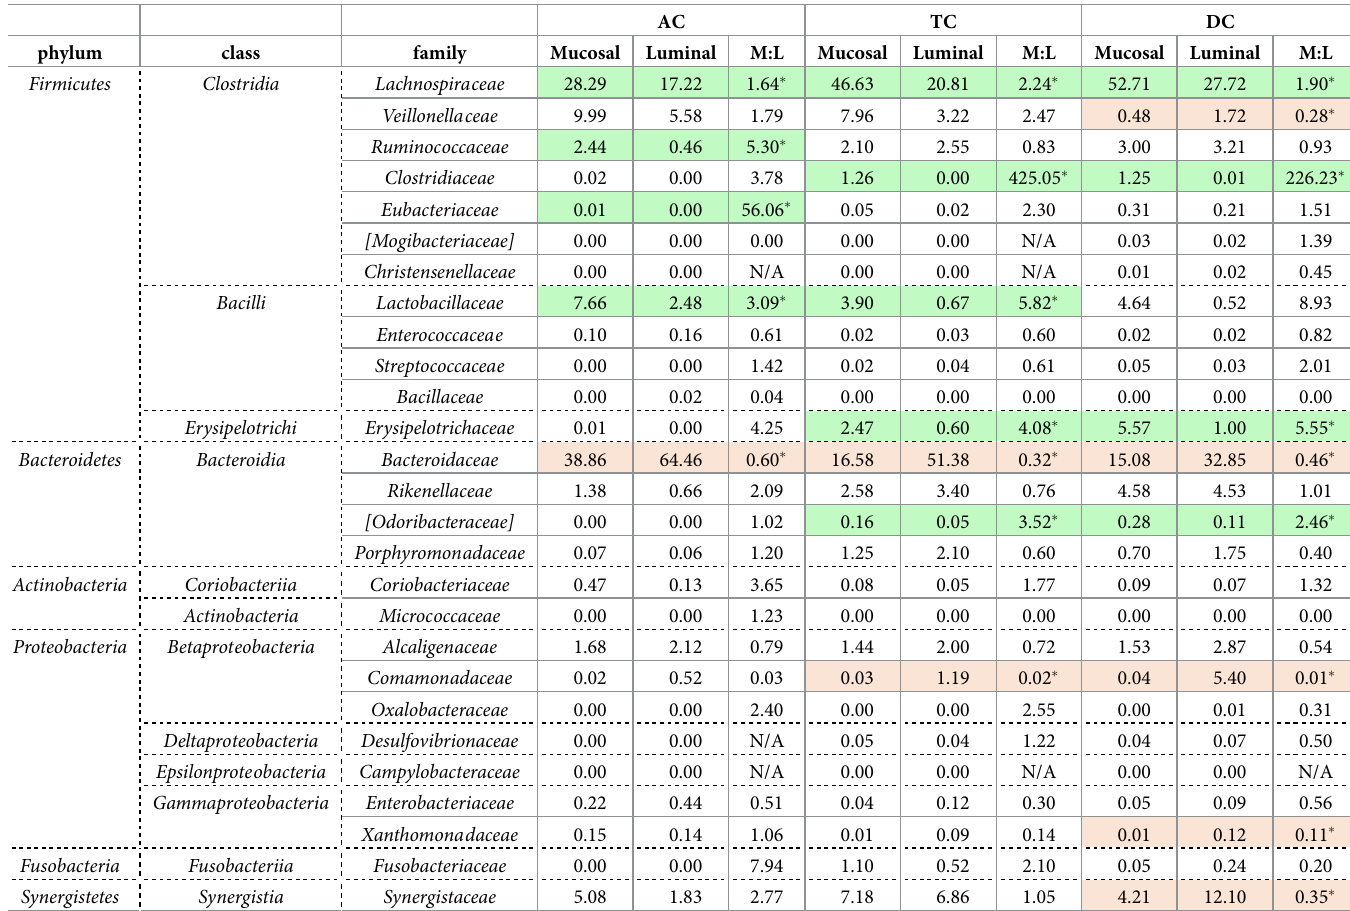
Table 1. Percent relative abundance at the family level for the mucosal and luminal phases of each region after stabilization (greater than .01% abundance for one region). M:L refers to the mucosal abundance divided by the luminal abundance. The green shading represents families with a significant increase in mucosal abundance and pink shading represents families with a significant decrease in mucosal abundance. A (cid:3) indicates that p < .05 according to a 2 tailed, student t -test corrected for multi- ple